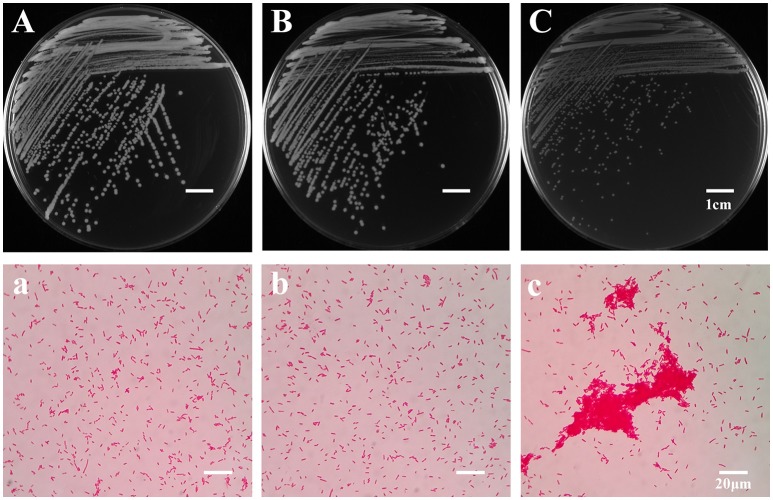
Colony and microscopic morphology of the ancestor, B strains (non-Tetrahymena-exposed) and SCV strains (Tetrahymena-exposed). The colony morphology of the ancestor (A), B1 (B), and SCV1 (C) strains on the LB plate were observed after culture for 20 h. The microscopic morphology of the ancestor (a), B1 (b), and SCV1 (c) strains were observed at 100 × magnification after Gram staining. The bar represents 1 cm in (A–C) and 20 μm in (a–c).